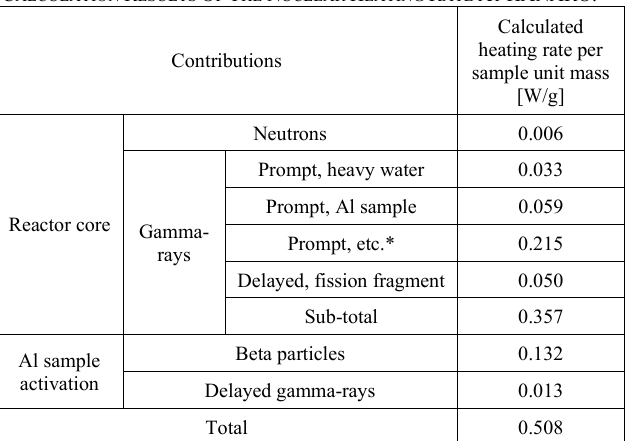
Fig. 6. Nuclear heating rate measurement at the three different reactor